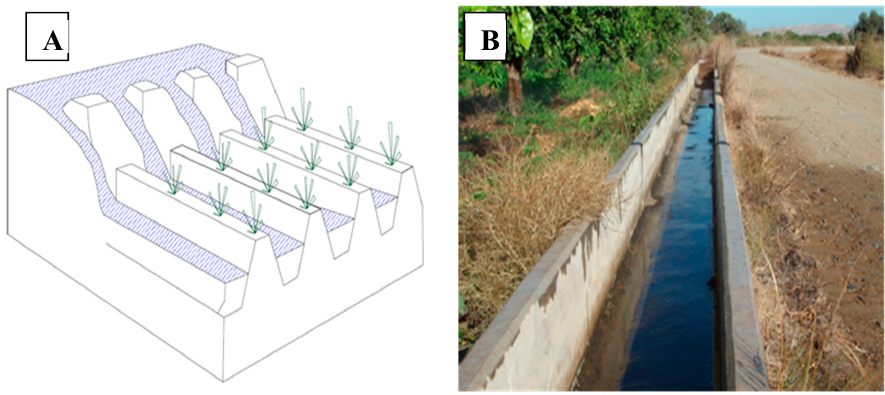
Figure 1. Traditional surface irrigation method (furrow irrigation, ( A )); open canal water distributing network ( B